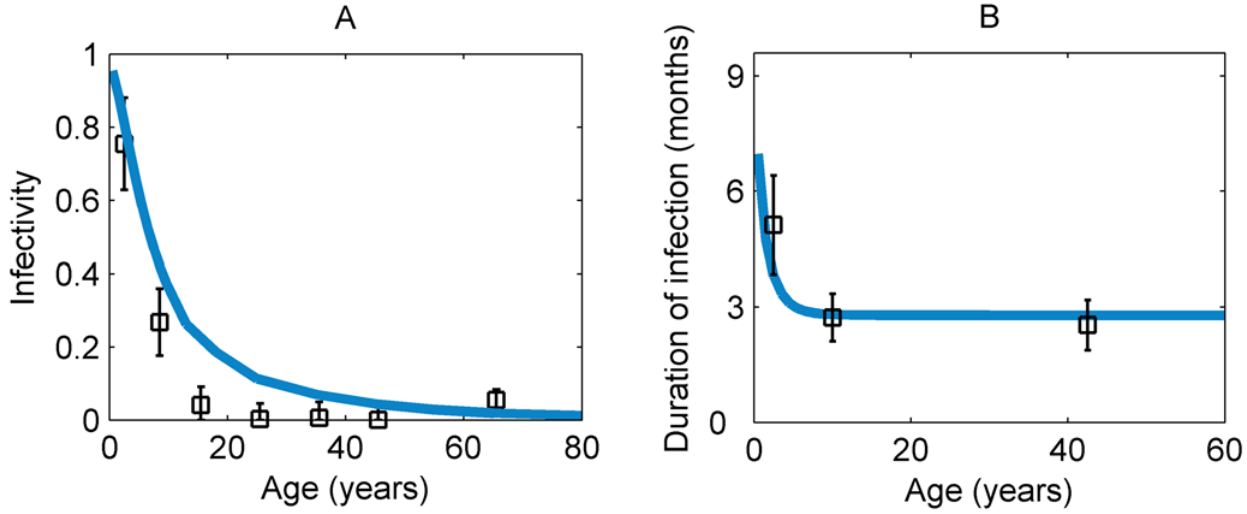
Figure 3. Model fits to hyperendemic data. Age-profiles generated by the maximum likelihood parameter estimates to the hyperendemic data set of West et al. [25] and—for the recovery rate—Bailey et al. [7], re-analyzed by Grassly et al. [3] (data displayed as square data points with 95% confidence intervals, and model fits shown as solid lines): A) the infectivity, which is proportional to the bacterial load, measured by quantitative PCR; B) duration of infection.